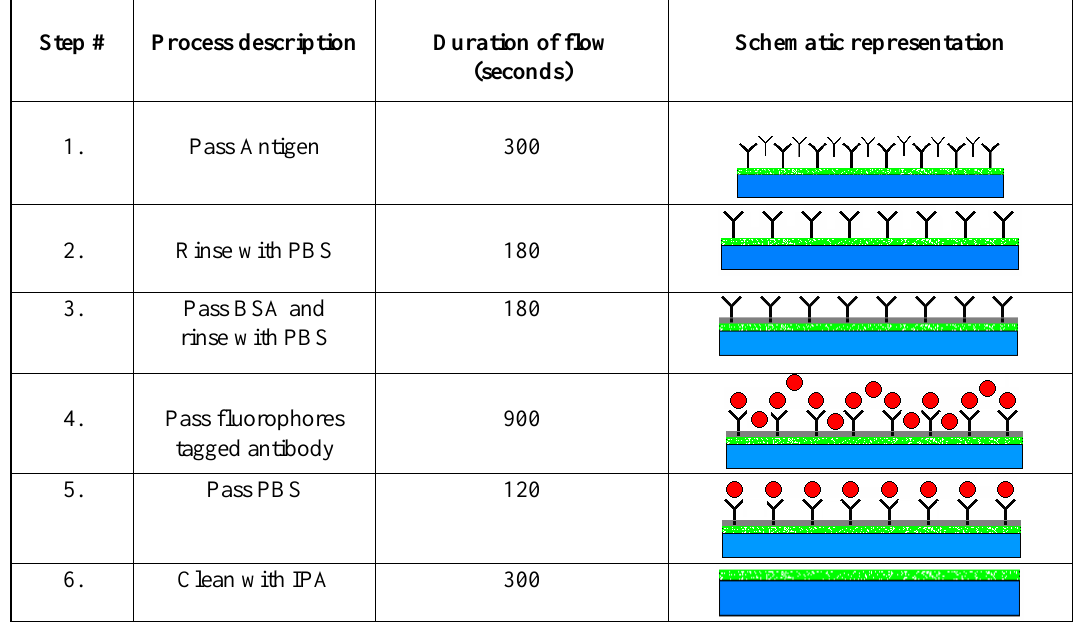
Table 1. Sequential experimental procedure for fluorescence detection with Alexafluor-